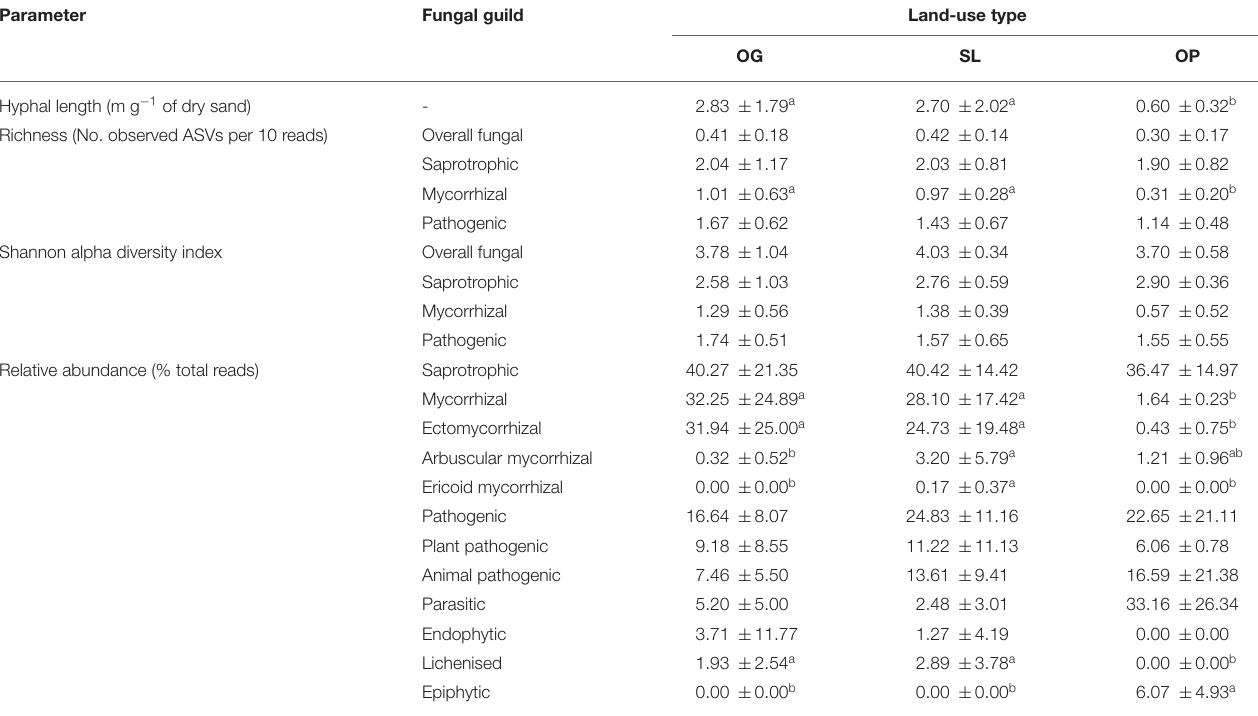
TABLE 3 | Mean ( ± 1 SD) mycelial production (hyphal length) and fungal guild community attributes (Amplicon Sequence Variant (ASV) richness, Shannon alpha diversity and relative abundances) by land-use type for old-growth (OG) and selectively logged (SL) lowland dipterocarp rainforest and oil palm plantation (OP) in Sabah, Borneo. Parameter Fungal guild Land-use type OG Hyphal length (m g − 1 of dry